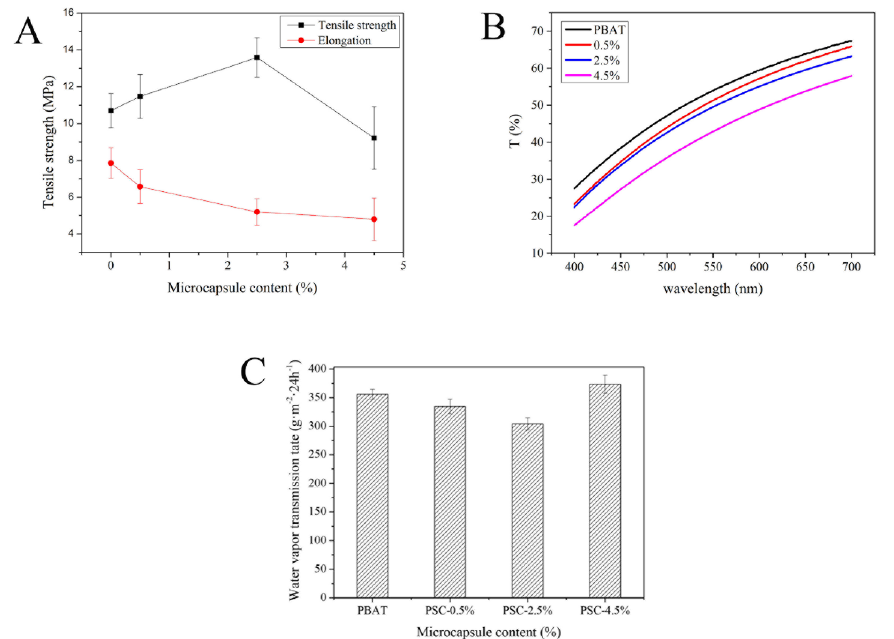
Figure 7. ( A ): Tensile strength and elongation at break of poly (butyleneadipate- co -terephthalate) (PBAT) and PBAT / SiO 2 -CA (PSC) films; ( B ): water vapor transmission rate (WVTR) of PBAT and PSC films; ( C ): transmittance of PBAT and PSC films.